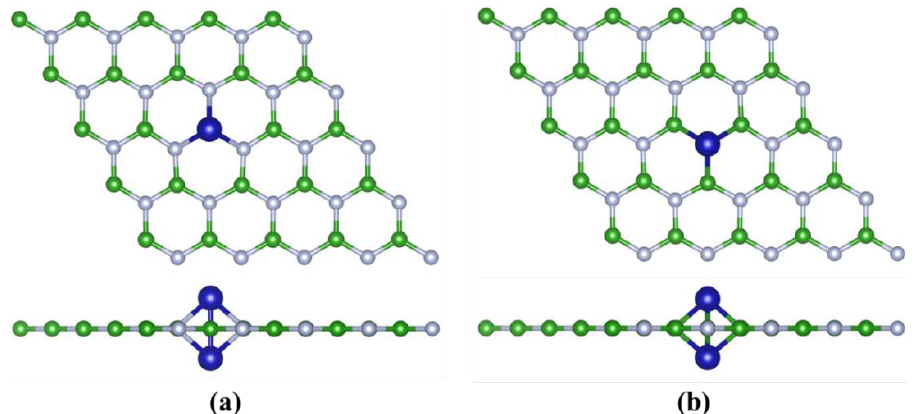
Figure 1. Structural diagram of the ( a ) M 2 ⊥ vb-BN and ( b ) M 2 ⊥ vn-BN models. Color scheme: B, green; N, silver; M, blue.